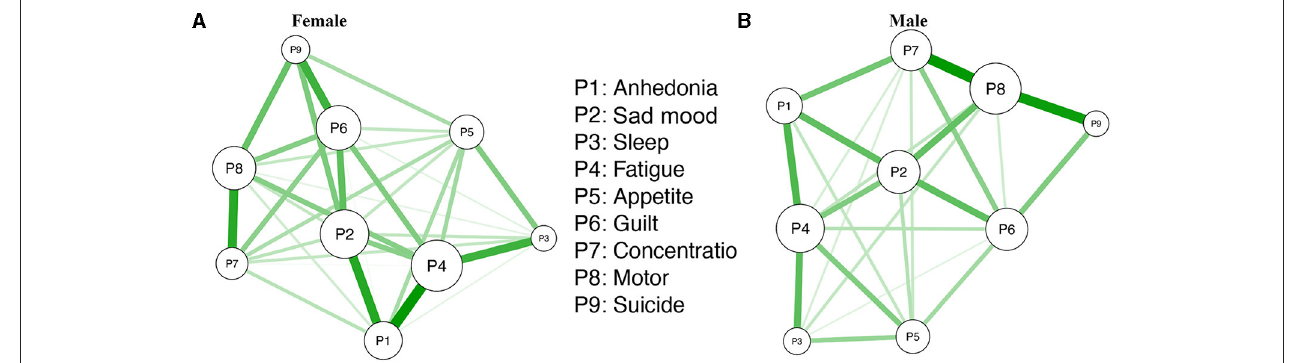
FIGURE 5 | (A,B) The estimated dichotomized depressive network model for female and male